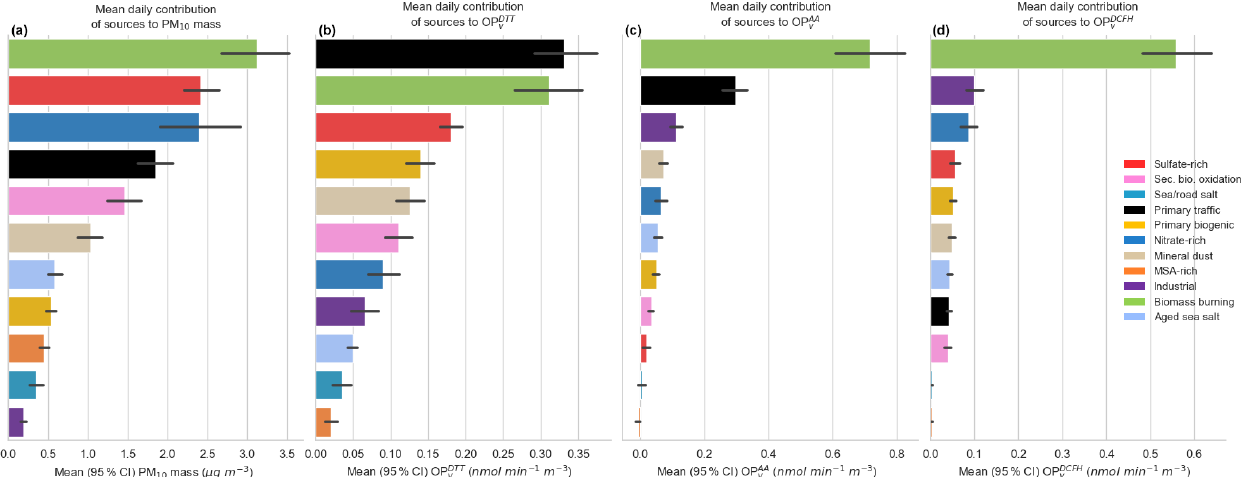
Figure 6. Overall daily mean OP v contribution of the sources to PM 10 , OP DTT v , OP AA v , and OP DCFH v using MLR analysis in the form of mean and 95% confidence interval of the mean (error bar) ( n = 378